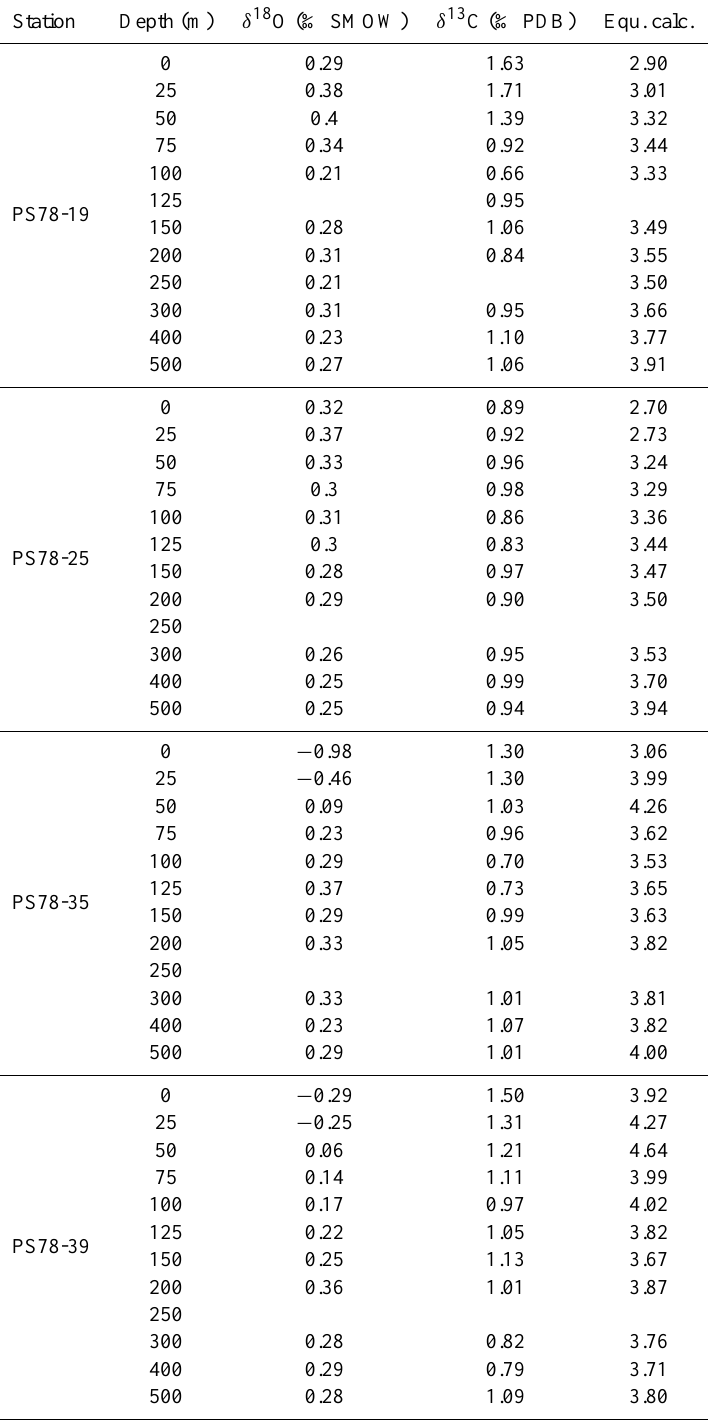
Table 2. δ 18 O, δ 13 C and equilibrium calcite values in the upper 500m of the water column.